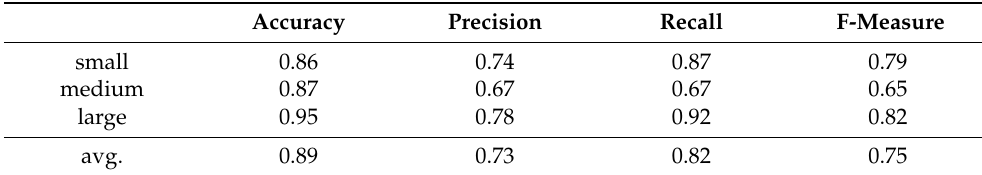
Table 4. Performance comparison of PDTS with respect to different document sizes: small ( | X | < 168), medium (168 ≤ | X | ≤ 512), and large (512 < | X | ). The base model is mBERT , and α = 40. For θ , the best value found in all our experiments is around